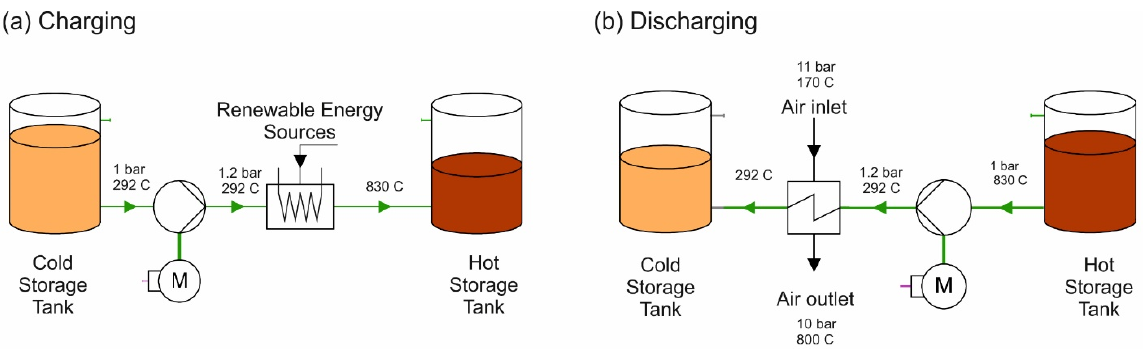
Figure 4. Schematic flow diagram of stand-alone molten salt energy storage system: ( a ) during charge mode and ( b ) discharge mode [15] .